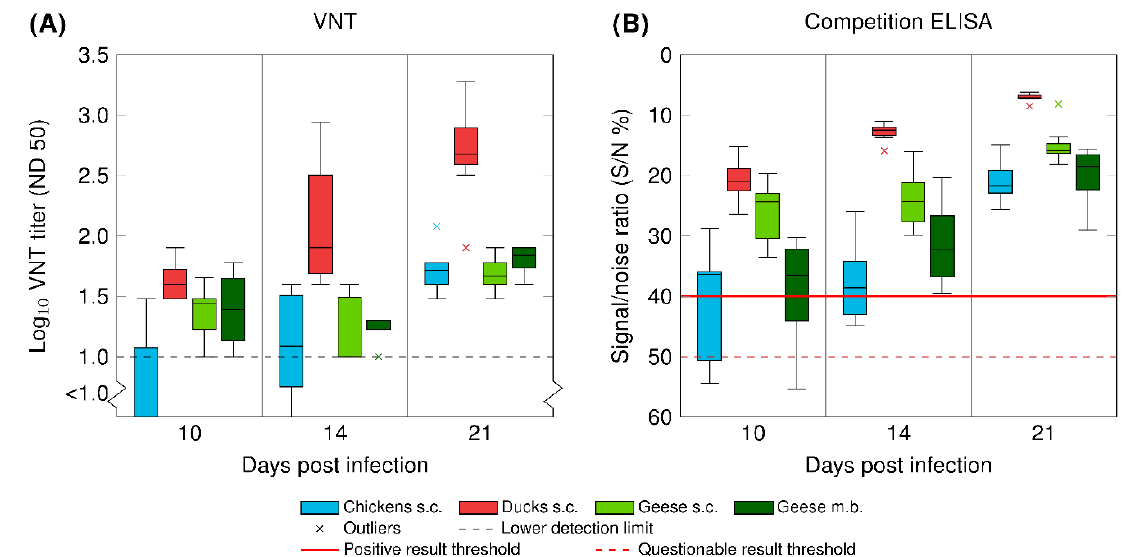
Figure 3. Seroconversion of chickens (in blue), ducks (in red), and geese (in green) after inoculation with WNV via subcutaneous injection (s.c.) or the bite of WNV-infected mosquitoes (m.b.; G 13 – G 16). ( A ) Antibody titers determined by a virus neutralization test (VNT) and ( B ) antibody titers determined by a commercial competition ELISA. Data are presented in a box-and-whisker plot, where the ends of the whiskers represent the minimum and maximum values. Outliers are represented by an x instead of the whisker-ends. The box includes 50% of the values of each group and the line in the middle of each group represents the median